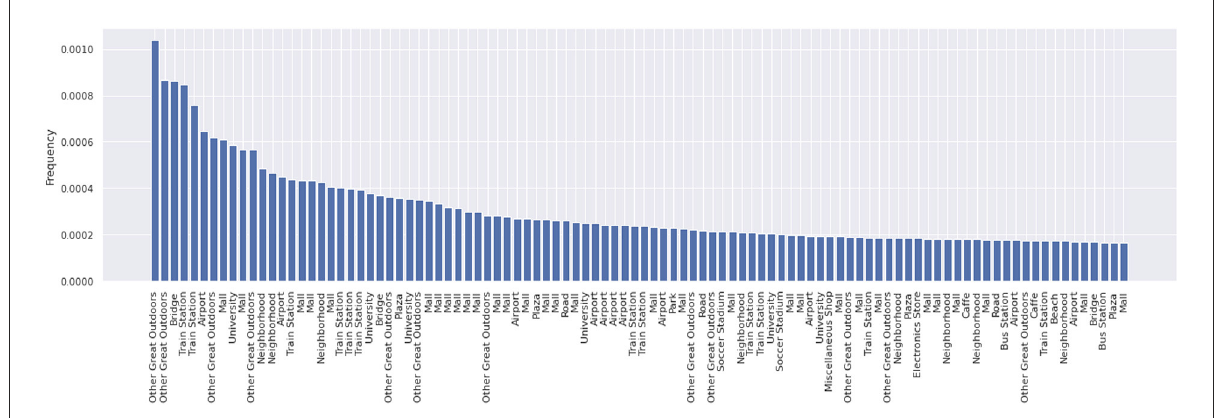
FIGURE2 Top 100 places ranked by the number of check-ins scaled by the overall number of check-ins in the Foursquare dataset.